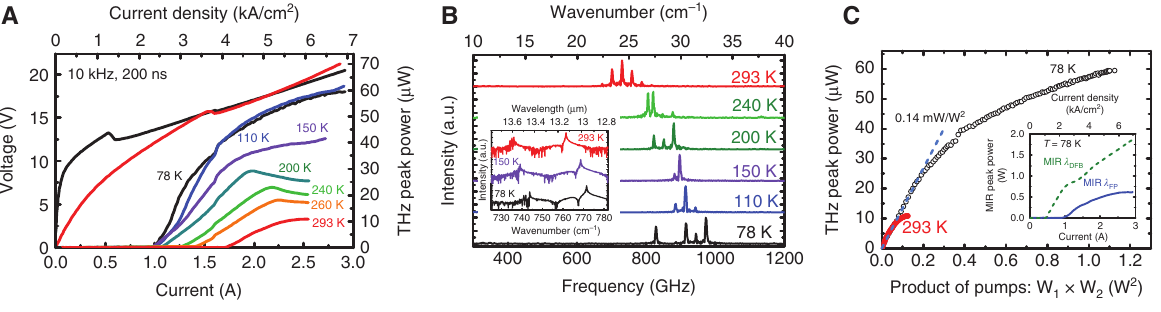
Figure 3: Temperature characteristics of the sub-THz source. (A) Current-voltage-THz-light-output characteristics of a 3.0-mm-long, 14- μ m-wide QCL source at different heat sink temperatures as measured in pulsed mode. (B) THz and MIR (inset) emission spectra of the device in (A) measured at different temperatures. (C) THz peak output power vs. the product of the MIR pump powers at 78 and 293 K. The MIR FP (blue solid line) and DFB pump powers (dashed lines) vs. the current density at 78 K are shown in the inset.